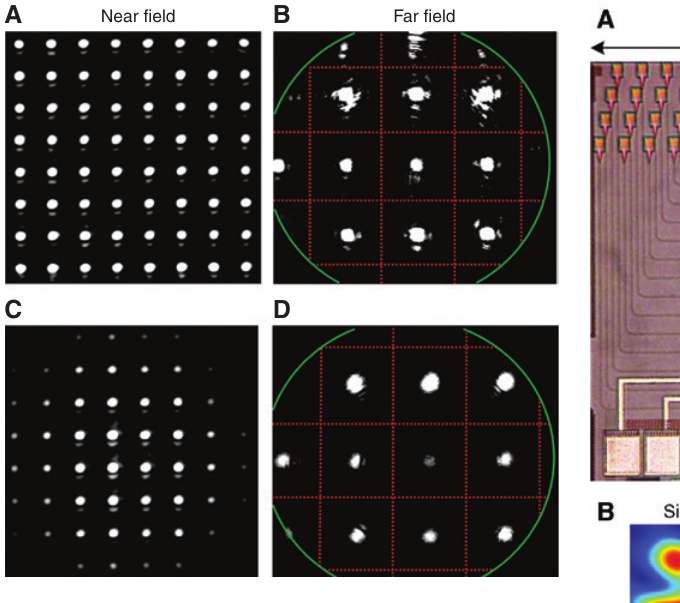
Figure 6: Apodization to suppress side-lobes. Measured (A, C) near-field emission and (B, D) far-field optical beam profile, obtained using a uniform and Gaussian- apodized 8 × 8 OPA, respectively. Reprinted by permission of The Optical Society